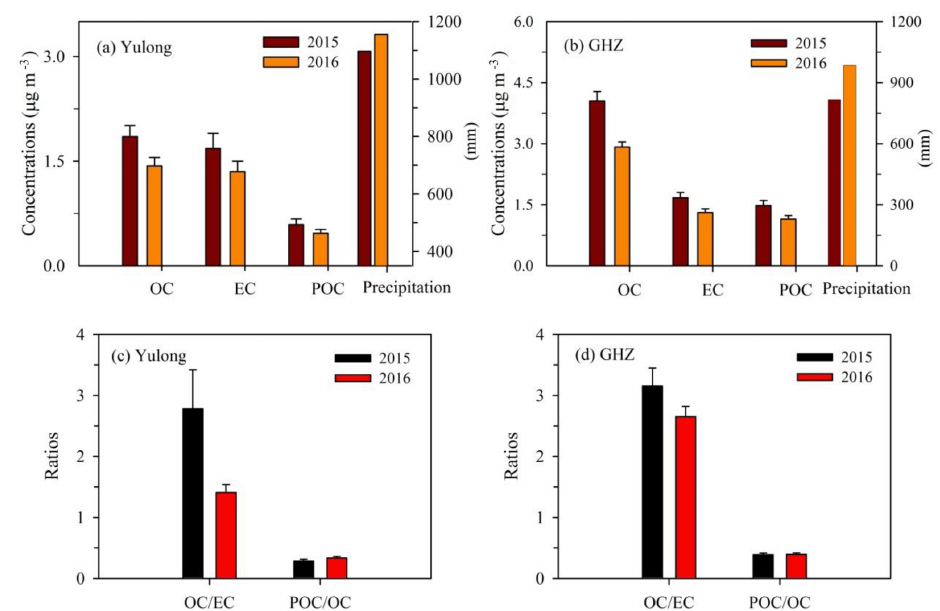
Figure 11. Inter-annual differences of OC, EC, and POC concentrations at the (a) Yulong and (b) GHZ site. Precipitation at Mt. Yulong and GHZ sites in different years was also plotted in (a) and (b) . The OC / EC and POC / OC ratios are shown in (c, d) .